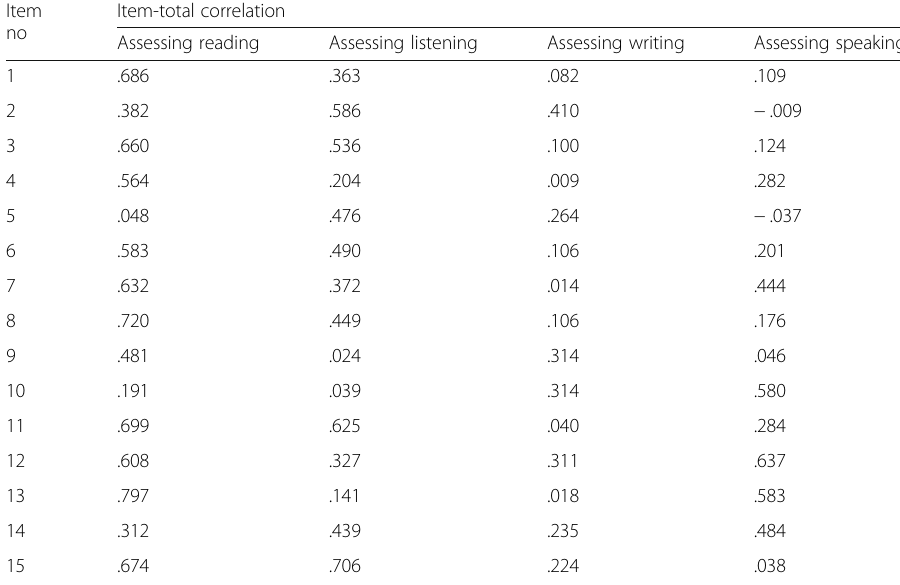
Table 6 Item-total correlation coefficients of the items under each skill Item Item-total no